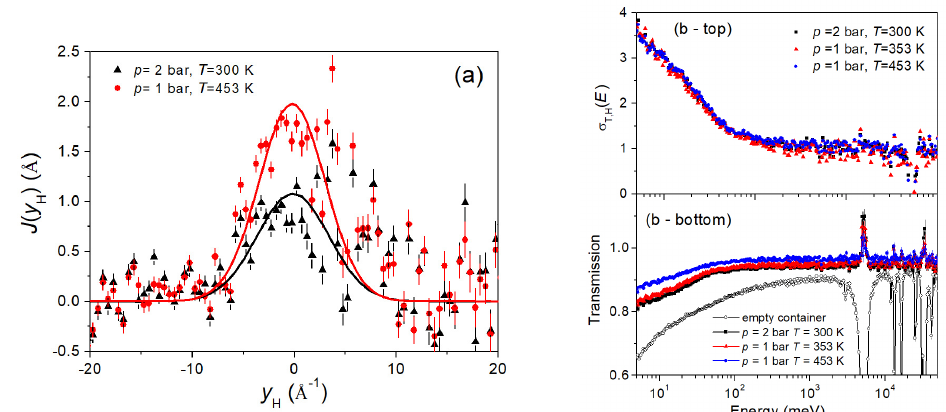
Figure 7. (color online): ( a ) The hydrogen neutron Compton profile at 2-bar loading and 300 K (black triangles), and at 1-bar loading and 453 K (red circles) in the West-scaling representation after background subtraction. Solid lines correspond to Gaussian fits with fixed widths using the Incoherent Inelastic Neutron Scattering (IINS) results (see main text for details); ( b ) neutron transmission (bottom right panel) and total cross-section (top right panel) for H in the previously mentioned conditions and at 1-bar loading and 353 K (red triangles), together with the corresponding signals for the empty Pd-Ag membrane (black line and empty circles).